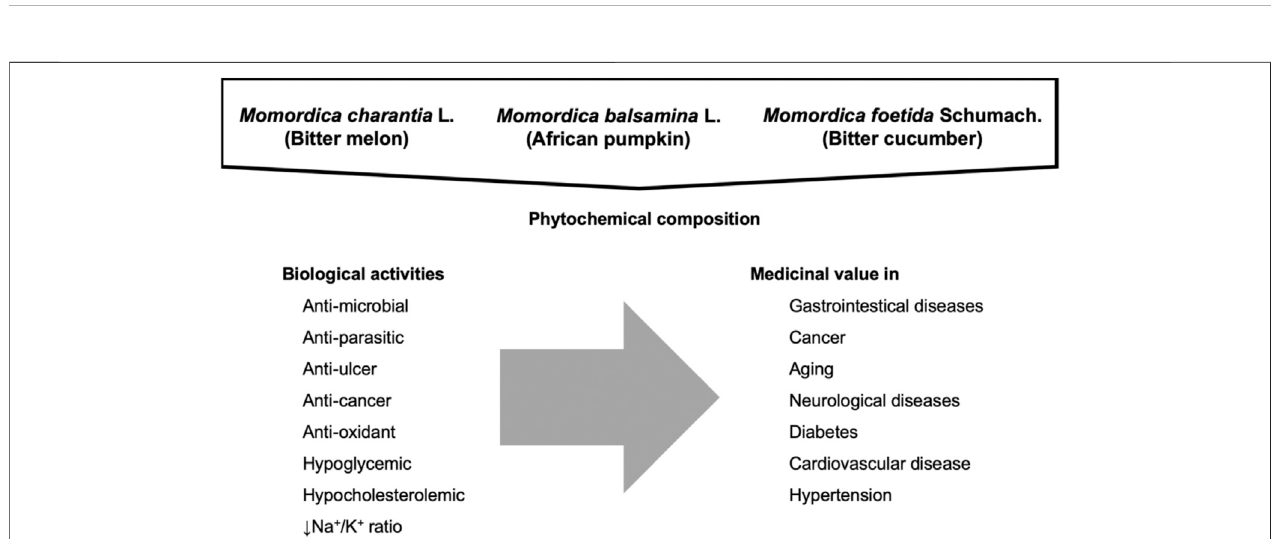
FIGURE 2 | Summarized biological activies and medicinal value of Momordica charantia L. Momordica foetida Schumach. and Momordica balsamina L. (African pumpkin).